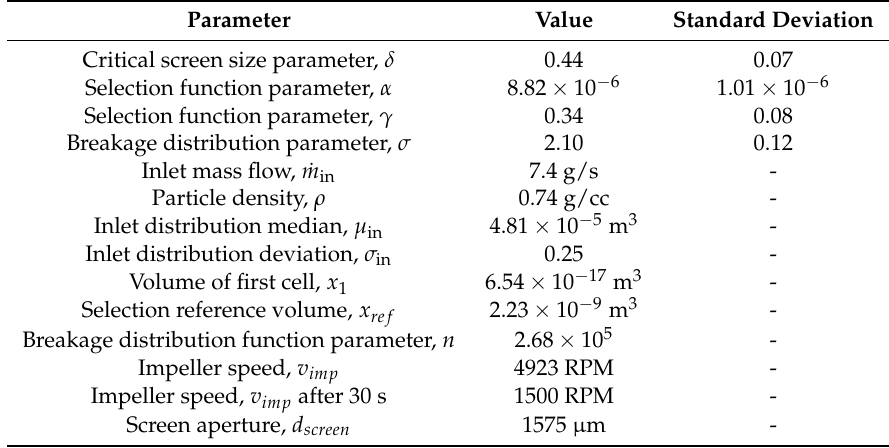
Table 1. Parameters and operating parameters for the cone mill adapted from